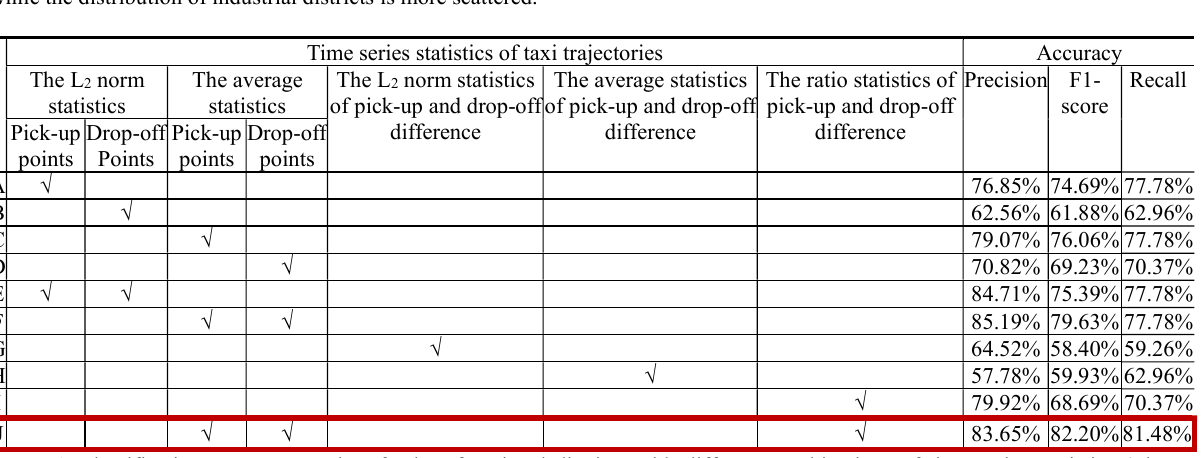
Figure 6. Spatial distribution of 269 functional districts in Wuchang (Zhang et al., 2020).